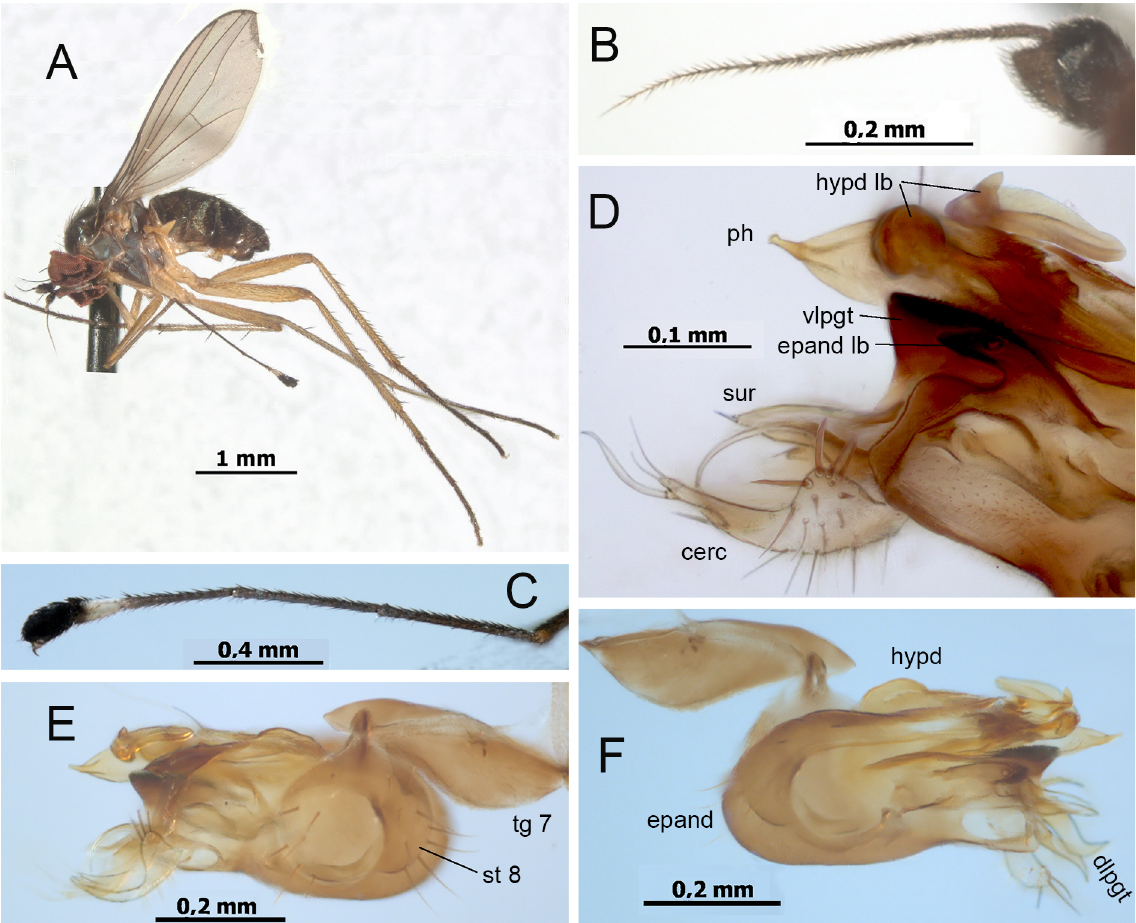
Fig. 2. Hercostomus fedotovae sp. nov., ♂, holotype (ZMUM). A . Habitus. B . Antenna. C . Fore tarsus. D . Distal appendages of epandrium. E . Hypopygium, left lateral view. F . Hypopygium, right lateral